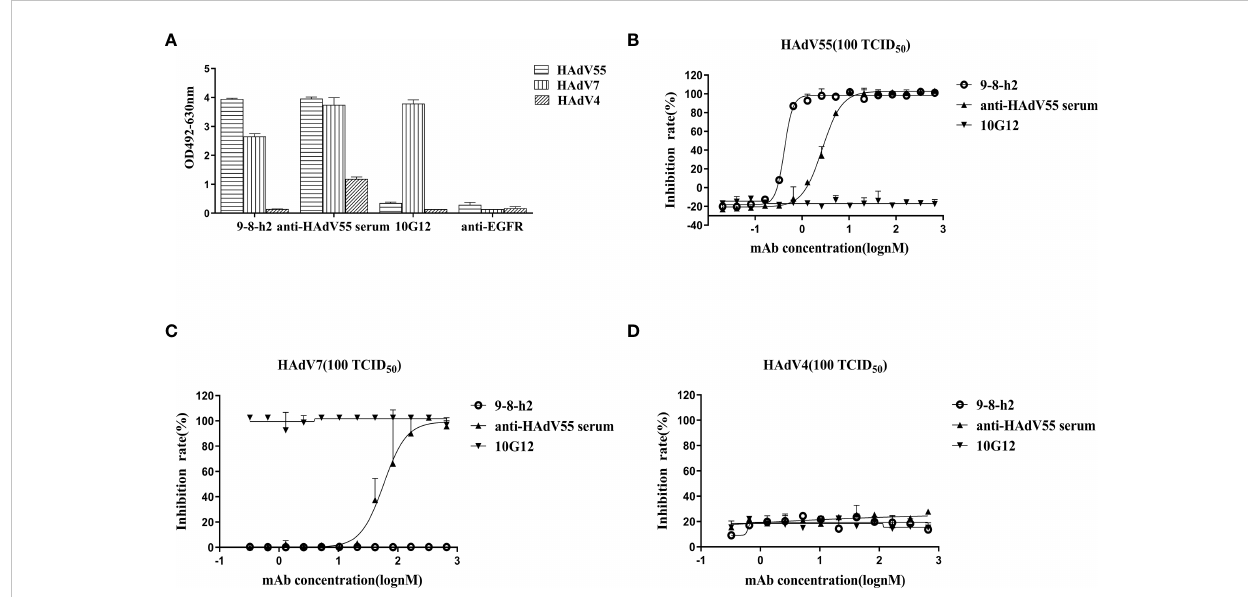
FIGURE 4 Humanized mAb 9-8-h2 cross-reacts with several types of HAdV. ELISA detection of humanized mAb 9-8-h2 reacting with puri fi ed virions from HAdV4, HAdV7, and HAdV55 (A) . n = 3 independent experiments; data are shown as the means ± SD. Humanized mAb 9-8-h2 was assessed for NAb titers to HAdV55 (B) , HAdV7 (C) or HAdV4 (D) viruses using an in vitro micro-neutralization